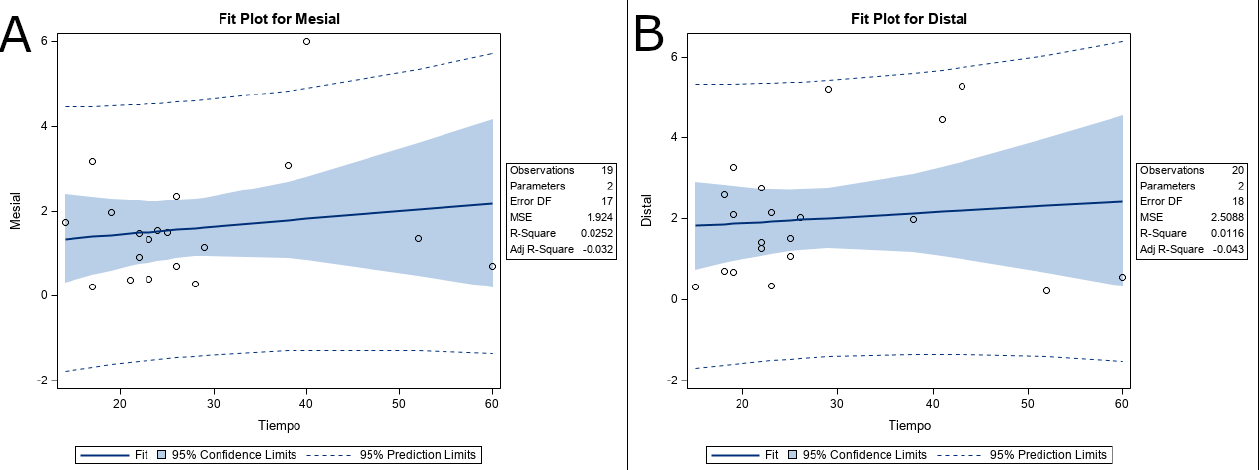
Figure 7. ( A ) Fit plot of the relationship between the dentin removal and the working time of the removal systems at the messiobuccal and ( B ) distal root canal systems. In summary, no differences in overall change in dentin volume were observed between the US and ER study groups after dentin removal. The most important result is that the US study group allowed the removal of 8 out of 20 fractured NiTi endodontic rotary files (1 in the mesiobuccal root canal system and 7 in the distal root canal system) from the root canal system; meanwhile, the ER study group allowed the removal of 3 out of 20 fractured NiTi endodontic rotary files (all in the distal root canal system) from the root canal system. Therefore, the US removal system is recommended for the removal of fractured files from the root canal system.